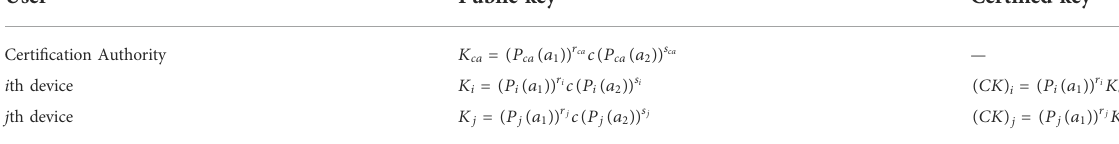
TABLE 3 Certi fi cation Authority ’ s public database.